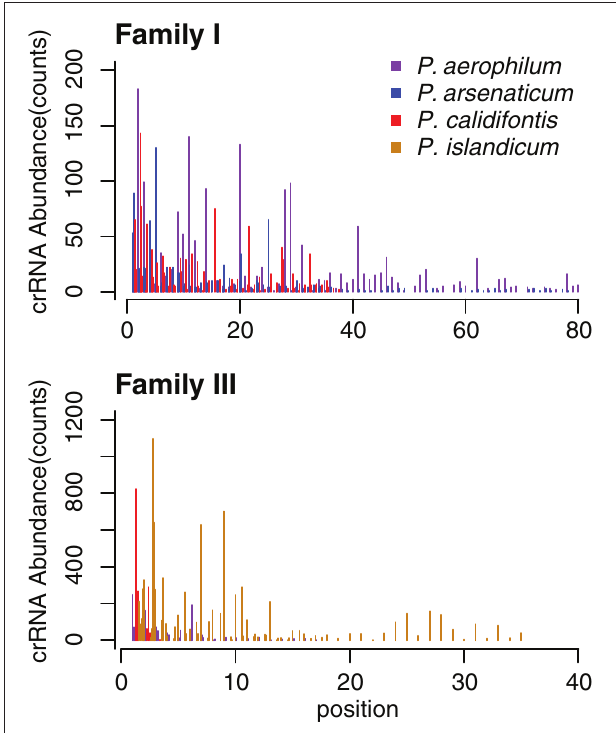
FIGURE 4 | CRISPR small RNA abundance density in Pyrobaculum CRISPR arrays by family. Abundance is depicted on the vertical axes, in each species at every spacer position in the array. The horizontal axes plot crRNA genetic origin in terms of spacer number within CRISPR arrays, starting at the 5 (cid:2) end of arrays. The abundance profile appears higher at the 5 (cid:2) portion CRISPR arrays, with considerable variation deeper (3 (cid:2) ) in the array. Multiple arrays of the same type within a species are plotted as adjacent bars by spacer